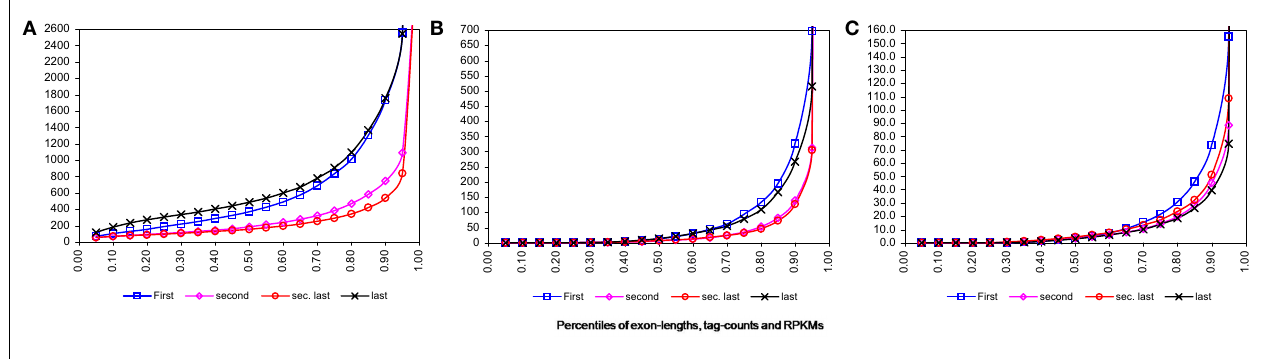
been omitted. (A) Percentiles of lengths of exons. (B) Percentiles of tag counts mapped to exons for wild-type plants. (C) Percentiles of RPKM, i.e., tag counts adjusted by length, for exons for wild-type plants.